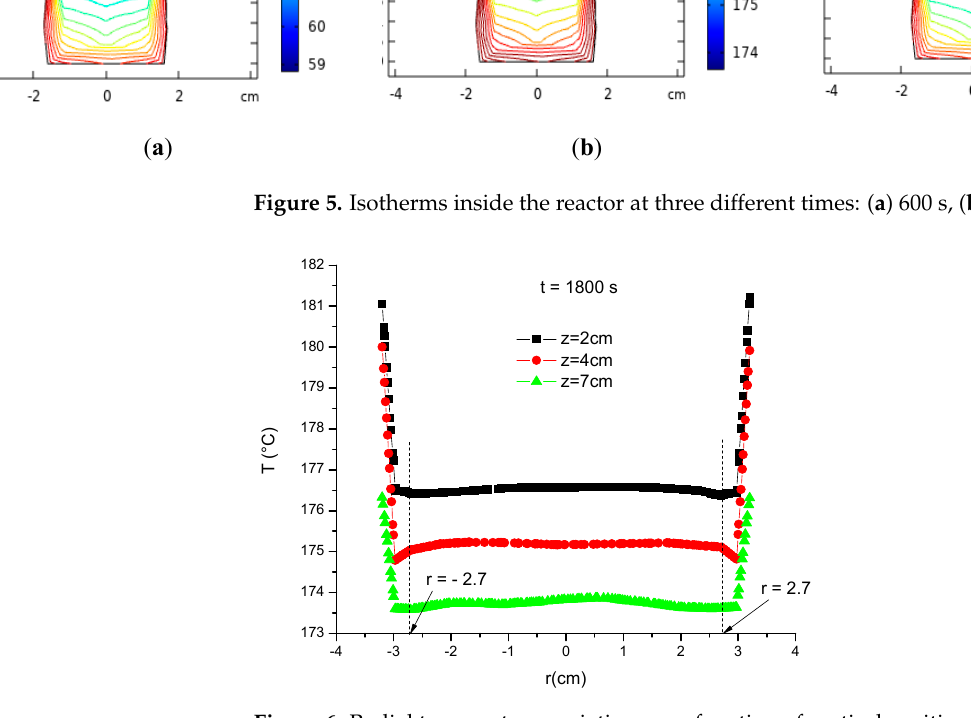
Figure 6. Radial temperature variations as a function of vertical positions at t =1800 s.